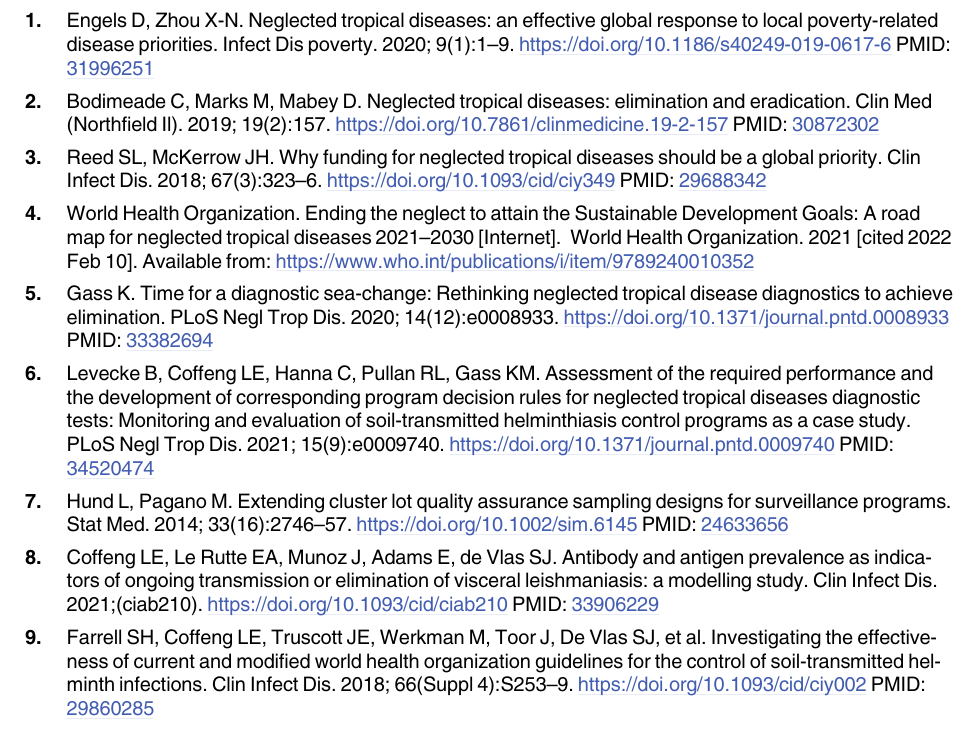
S1 Fig. The relationship between the risk of under and overtreatment when deploying per- fect diagnostic test. ε : probability of prematurely reducing interventions within an undertreat implementation unit i ; ε : probability of falsely continuing or upscaling an intervention overtreat frequency within an implementation unit i . The blue indicates the area in which the combina- tion of the risk of under and overtreatment allow for adequate decision-making ( ε 5 %, ε = 25 %). We defined the grey zone as T ± 50 % ( 2 %: lower limit = 1 % and upper overtreat was set at 0.02 and the number of clusters at 5 and limit = 3 %). The intra-cluster correlation ρ i the number of subjects per cluster at 50. The graph was based on 10,000 Monte Carlo simula-